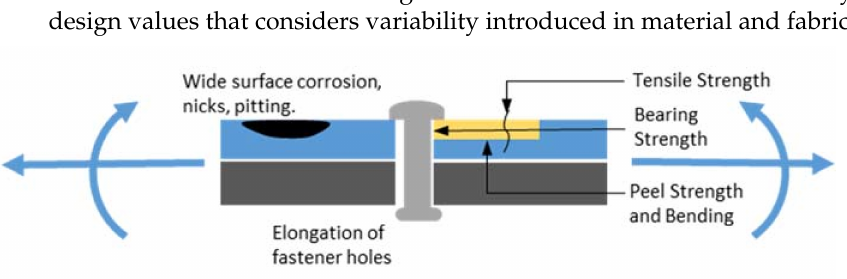
Figure 1. Schematic illustration showing defects on a typical skin panel or bracket.